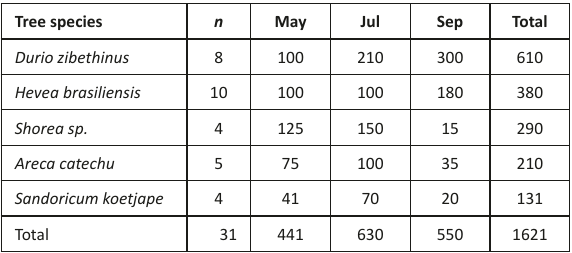
Image 4. Photograph of a single Flying Fox from a colony of Pteropus sp. at Kyaung-gyi monastery in Nyaung-zin village. The ventral pelage of individual bats varied from light orange tan (above) to mid-brown.